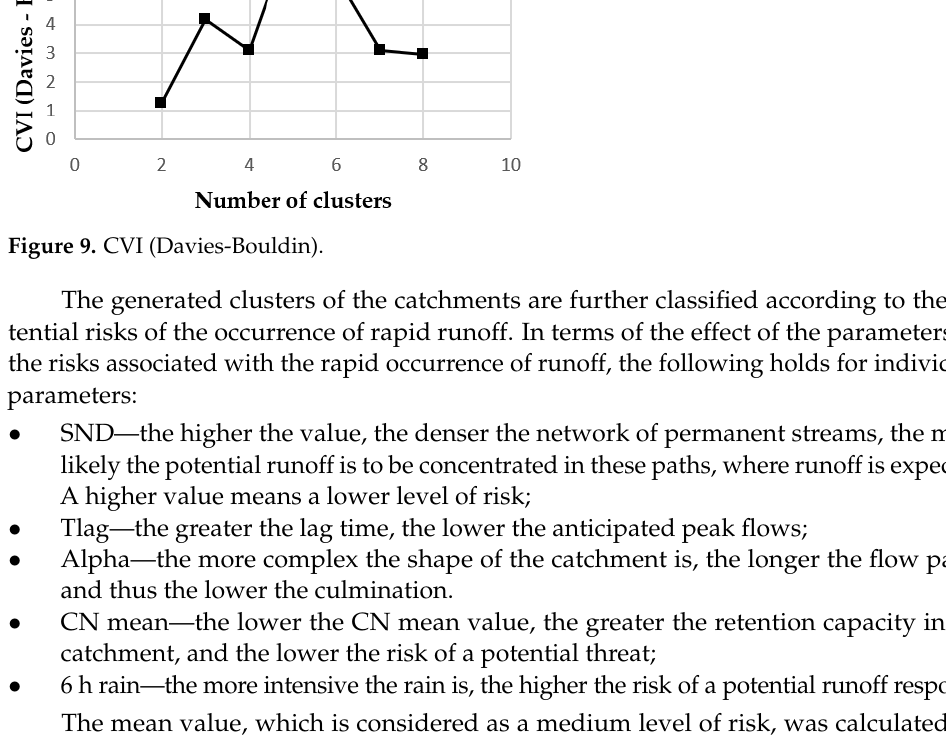
Figure 8. Geographical representation of the development of the groups during the formation of two to eight ( a – g ) clusters. The Davies-Bouldin index was used to determine the optimal number of clusters using Clustering Validity Indices (CVI) (Figure 9). The optimal number of clusters from this is five. A suitable number of clusters is six, from which completely new class D arises (described in more detail in discussion).